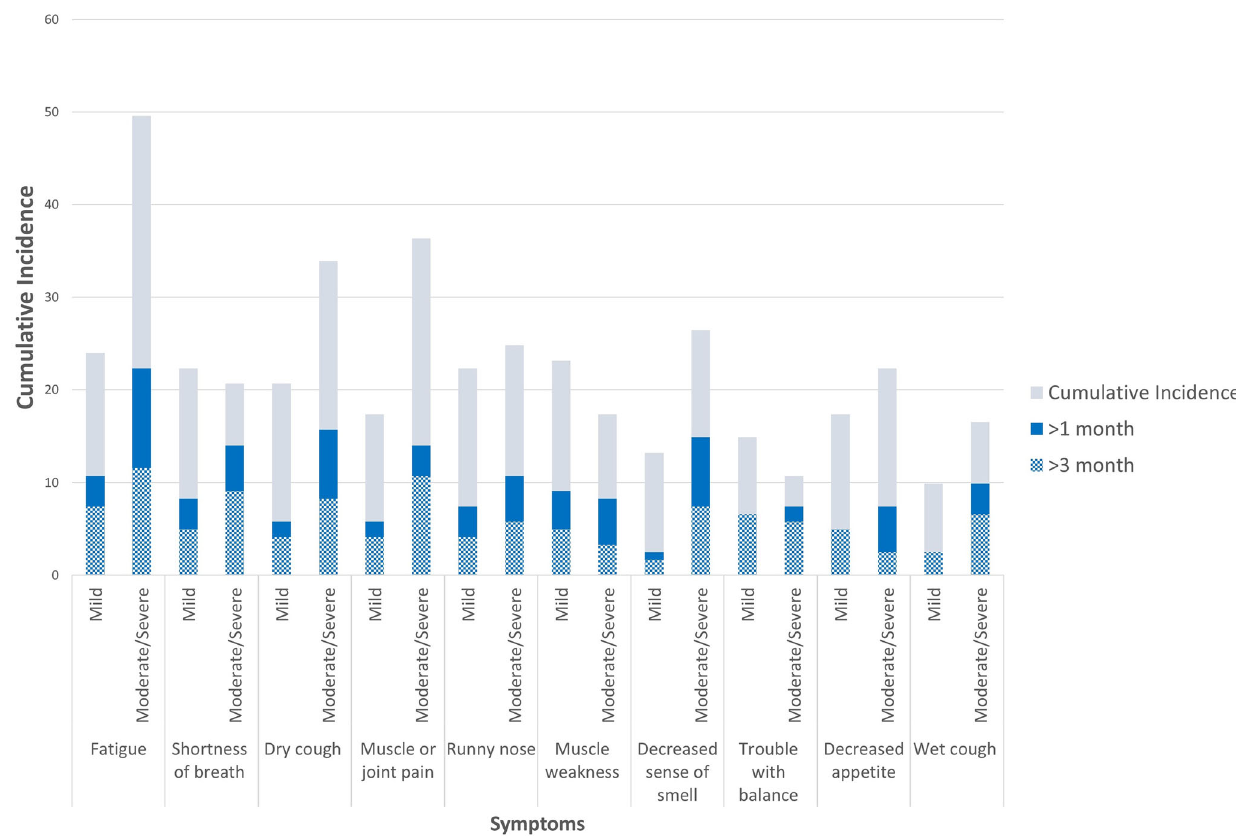
Fig. 3 Overall cumulative incidence of persistent symptoms. Overall cumulative incidence percent (light blue) and cumulative incidence percent of symptom persisting for >1 month (dark blue) and >3 months (hatched blue) by severity for the ten most persistent symptoms in CLSA COVID-19 study participants with COVID-19 ( n = 121). Data to reproduce this fi gure are included in Supplementary Data